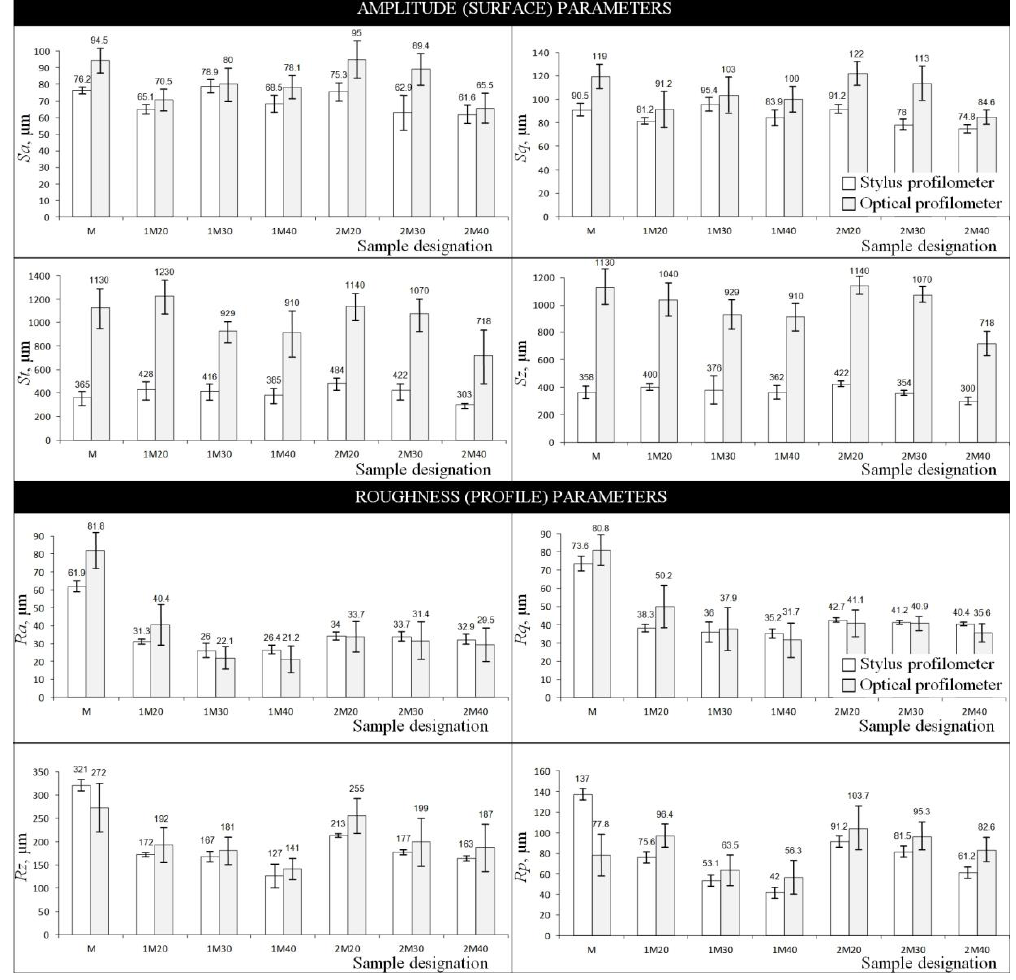
Figure 5. Values of selected ( a ) amplitude (surface) parameters, and ( b ) roughness (profile) parameters calculated on the basis of contact and non-contact measurements carried out using the stylus profilometer Hommelwerke Hommel-Tester T8000 (white bars) and optical profilometer Taylor Hobson TalySurf CLI2000 (gray bars) for samples used in the experimental studies. The analysis of parameters given in Figure 5 allows concluding that their values generally decreased depending on the concentration of impregnate substance introduced into the GWAS.